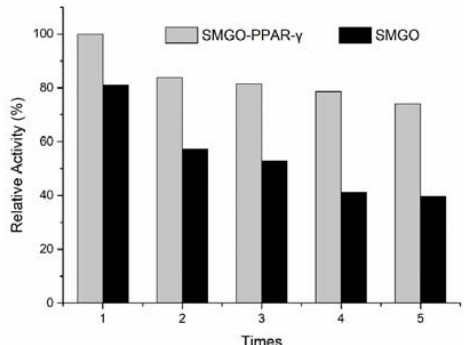
Figure 4. The relative activities of binding rosiglitazone in five consecutive association–dissociation cycles of ligand fishing assay eluent by SMGO-PPAR- γ and SMGO. Conditions: column: reversed phase symmetry C 18 (250 mm × 4.6 mm i.d., 5 μ m); mobile phase: NH 4 Ac in water (0.01 mol/L, pH